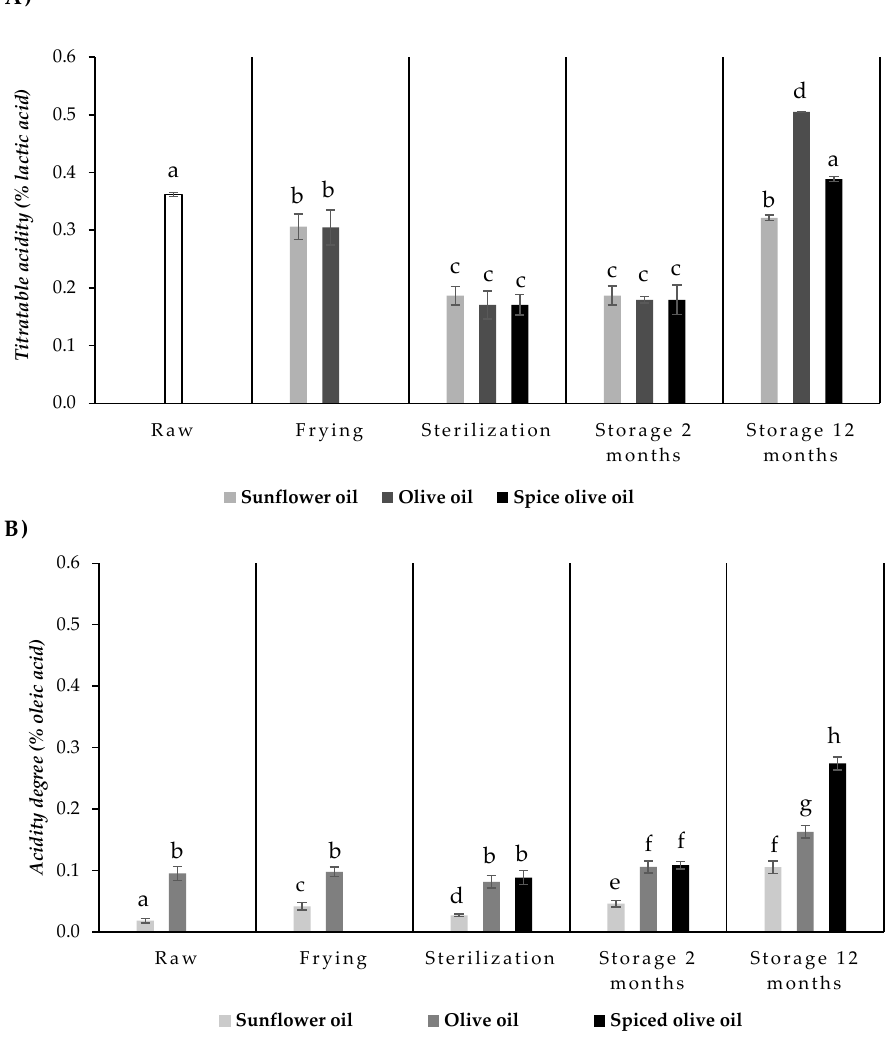
Figure 1. Titratable acidity (% lactic acid) of eels ( A ) and acidity degree (% oleic acid) of filling oils ( B ) throughout the different steps of the canning process (raw, after frying, and after sterilization process) and after 2 and 12 months of storage. Plotted values are mean of at least three determinations ± standard deviation. a–h Mean values with different letters are significantly different ( p < 0.05).